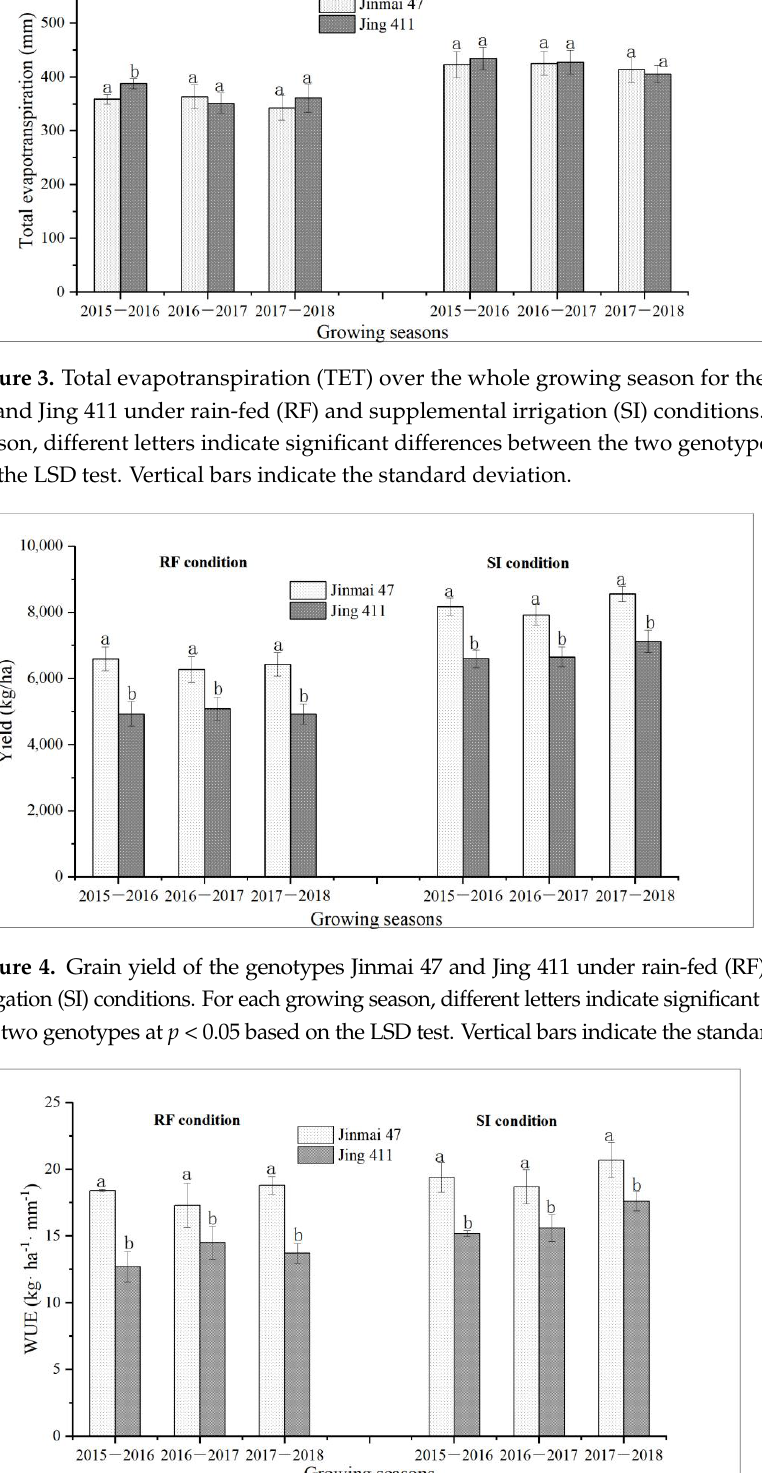
Figure 3. Total evapotranspiration (TET) over the whole growing season for the genotypes Jinmai 47 and Jing 411 under rain-fed (RF) and supplemental irrigation (SI) conditions. For each growing season, different letters indicate significant differences between the two genotypes at p < 0.05 based on the LSD test. Vertical bars indicate the standard deviation.